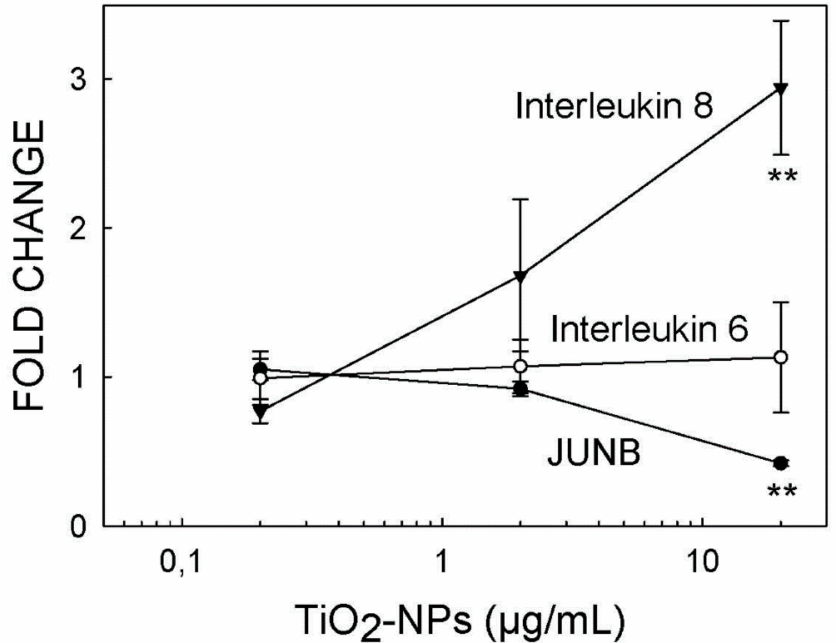
Figure 5. Effect of the concentration on alterations to the gene expressions induced by TiO 2 -NPs. The mean ± standard deviations of three biological replicates are displayed. ** = statistically different from the control for p < 0.01.